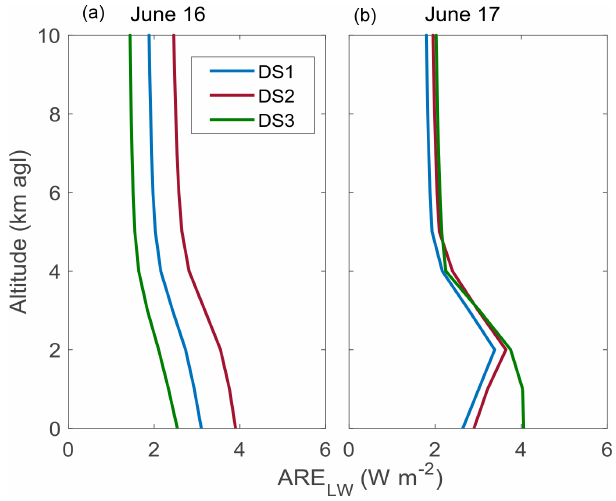
DS2, (cid:49) AOD ( (cid:49)r eff , c ) is − 0 . 04 ( + 0 . 18 µm), which